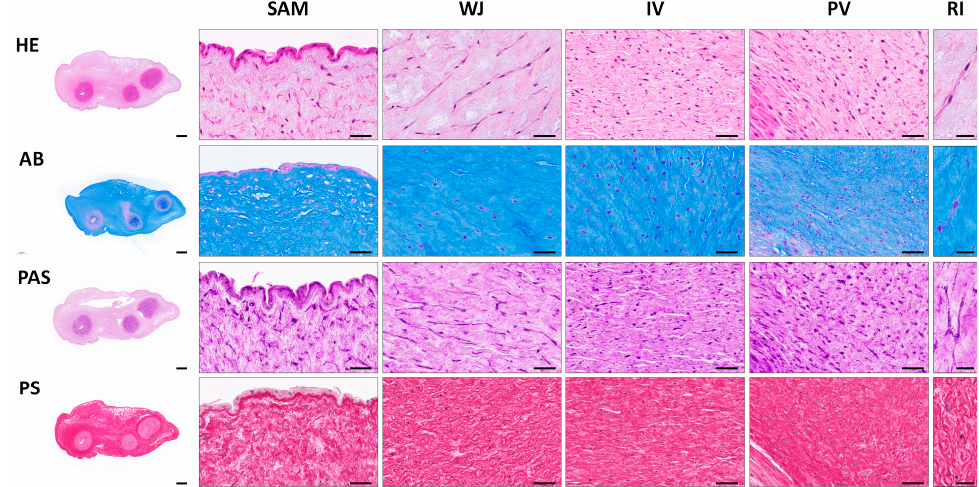
Figure 2. Histochemical analyses of full-term human UCs. Hematoxylin–eosin (HE), Alcian Blue (AB), Periodic Acid-Schiff (PAS) and Picrosirius Red (PS) methods were applied to analyze general morphology and synthesis of specific ECM components in complete UC (left) and specific regions; Sub-amnion (SAM); Wharton’s Jelly (WJ); intervascular (IV) and perivascular (PV). Representative images (RI) at higher magnification are shown on the right. Scale bar: 1000 µm (complete UC), 50 µm (specific UCs regions) and 25 µm (RI).